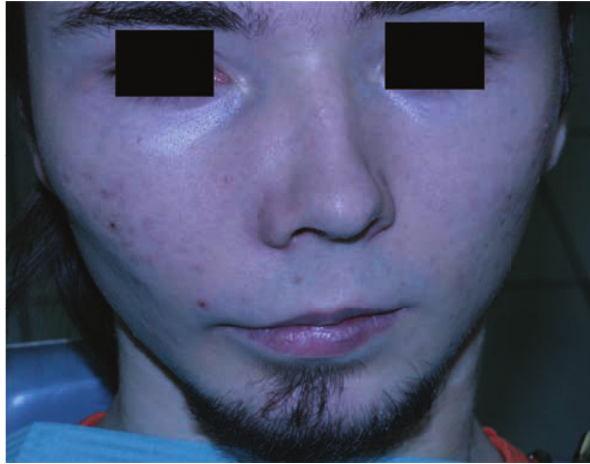
Figure 1: Patient K. M, aged 19. Facial asymmetry caused by eleva- tion in the zygomatic, infra-orbital and right nasal regions on the right hand side.